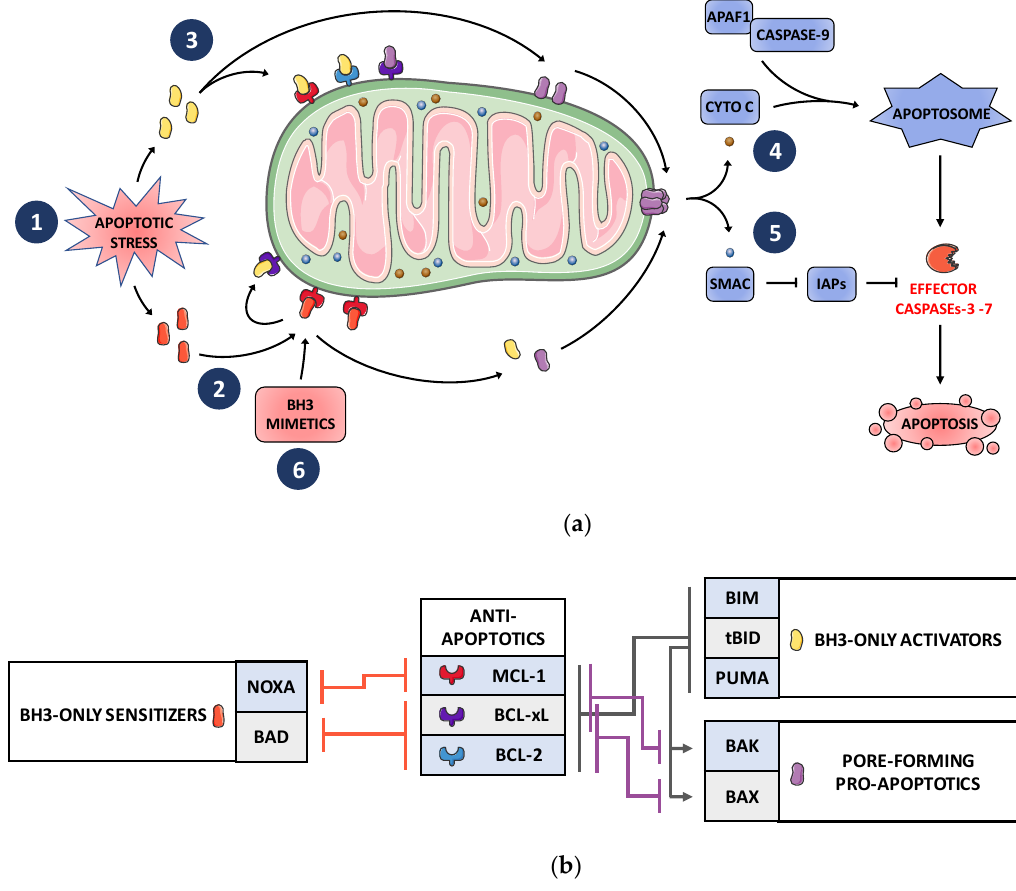
Figure 1. BCL-2 family proteins regulate MOMP through hierarchical interactions. ( a ) Upon apoptotic stress, 1. BH3-only sensitizers NOXA and BAD bind to MCL-1 or BCL-2 / BCL-XL, respectively, releasing BH3-only activators 2. and BH3-only activators (BIM, PUMA or tBID) bind to anti-apoptotics